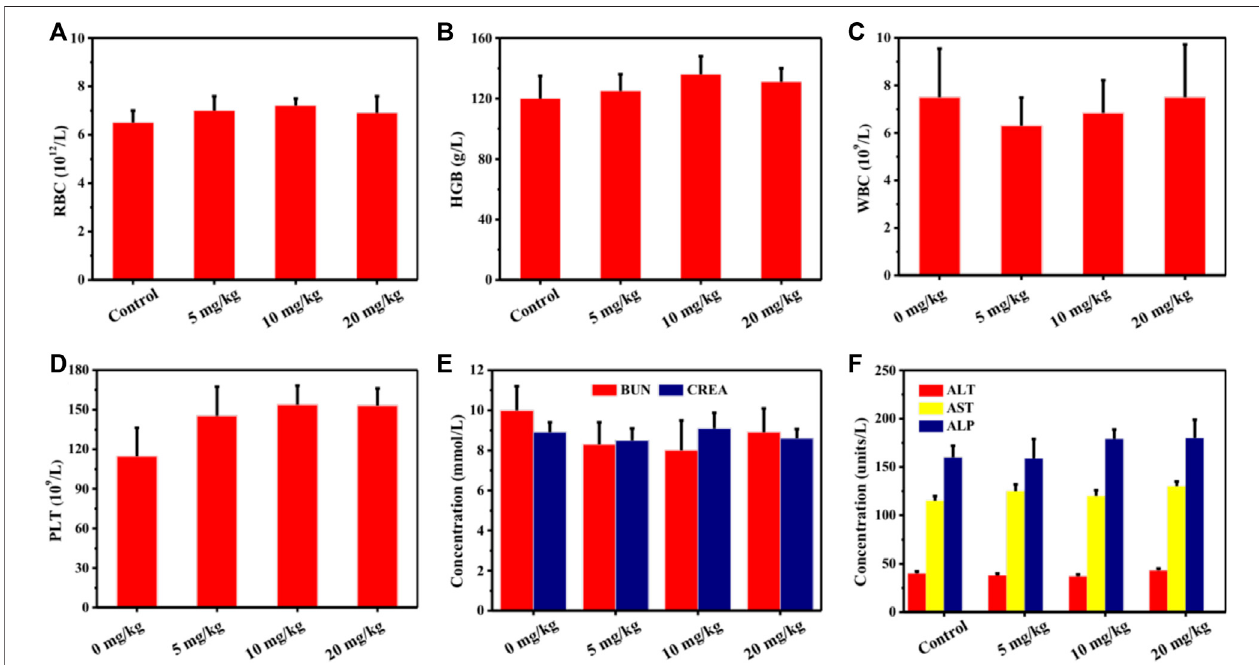
FIGURE 7 | Blood routine examination and serum biochemical levels of mice treated with 0 mg/kg, 5 mg/kg, 10 mg/kg, and 20 mg/kg of Cu-TCPP(Fe). (A) Red blood cell (RBC), (B) Hemoglobin (HGB), (C) White blood cell (WBC), (D) Platelet (PLT), (E) Blood urea nitrogen (BUN) and creatinine (CREA), (F) Alanine transaminase (ALT), aspartate aminotransferase (AST) and alkaline phosphatase (ALP) levels of mice in all groups.